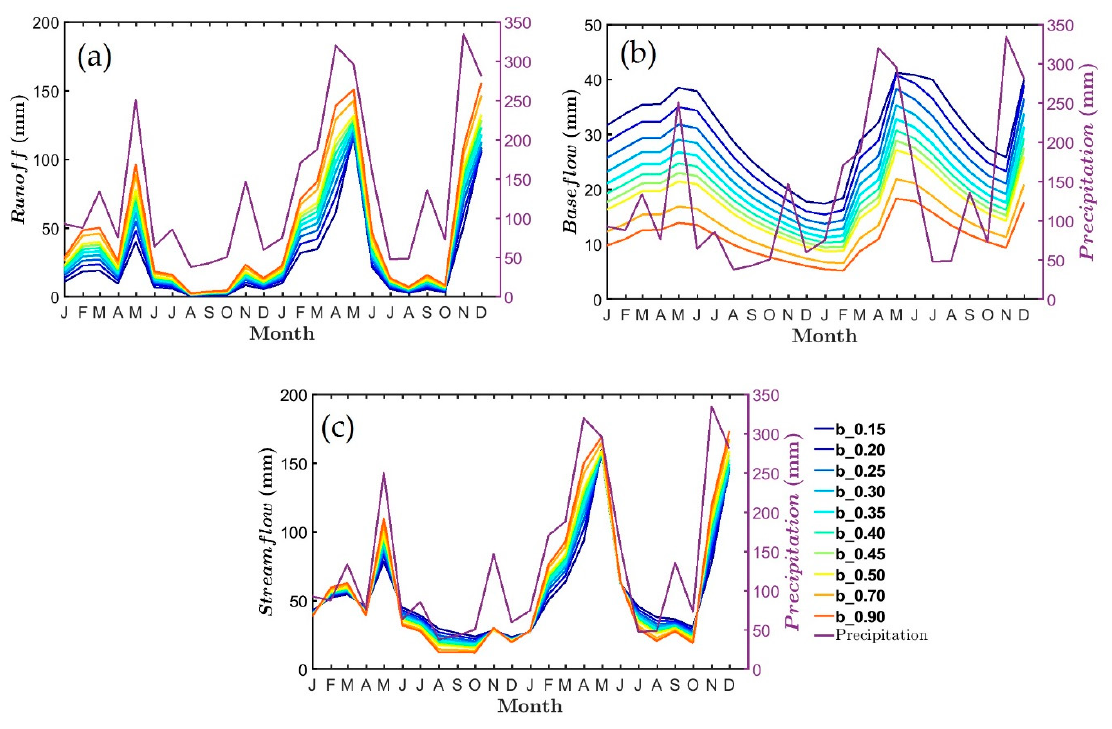
Figure 4. Sensitivity analysis of b and its effects on runoff ( a ), baseflow ( b ), and streamflow ( c ). The plots shows the monthly fluxes for the two years of 2010–2011.